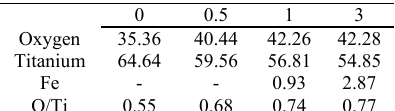
Table 2. Composition (% w/w) of pure and Fe doped TiO 2 nanoparticles